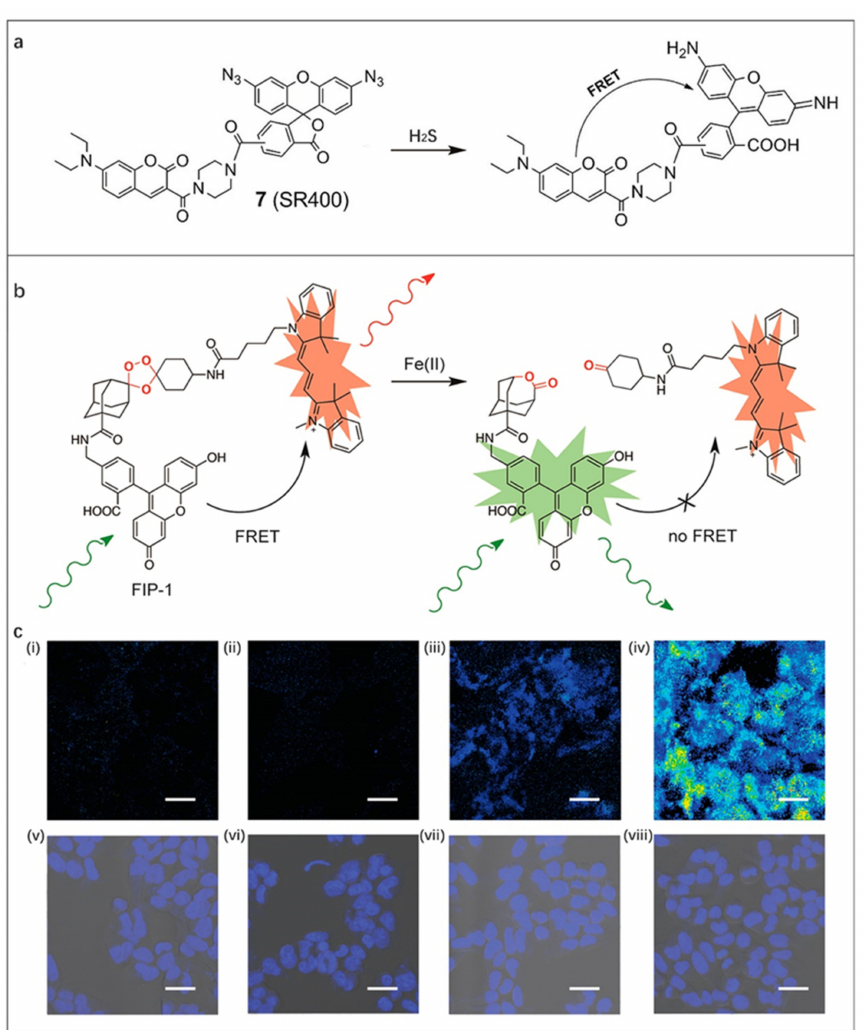
Figure 5. ( a ) The recognition mechanism of SR400 towards H 2 S. Reproduced with permission from Ref. [69], copyright 2022, Springer Nature. ( b ) Design of FRET Fe(II) probe FIP-1. ( c ) Represen- tative confocal microscopy images of live HEK 293T cells loaded with FIP-1. Cells treated with ( i ) 1 mM bathophenanthroline disulfonate for 9.5 h, ( ii ) 250 µ M deferoxamine for 9.5 h, ( iii ) vehicle for 90 min, ( iv ) 100 µ M ferrous ammonium sulfate for 90 min. ( v – viii ) Brightfield images of ( i – iv ) over- laid with Hoechst stain. Reproduced with permission from Ref. [71], copyright 2022, American Chemical